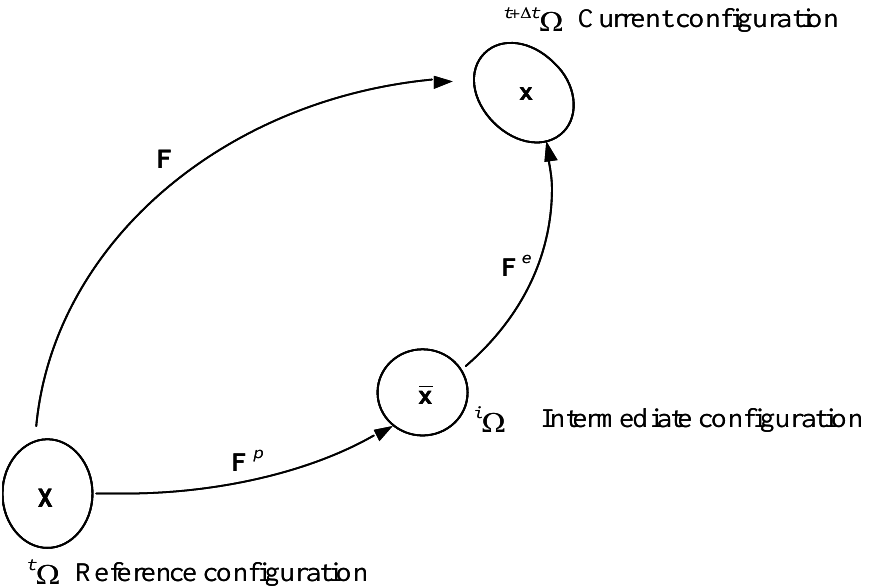
Figure 2. Multiplicative decomposition of elastic – plastic deformations.